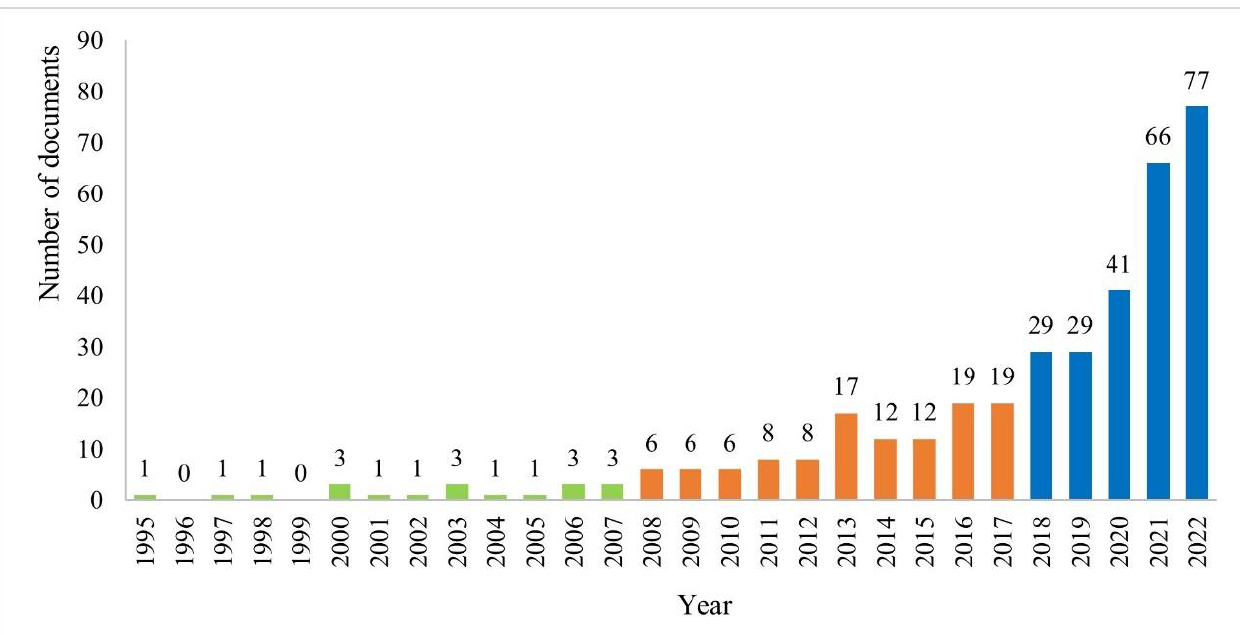
Figure 3. Annual number of documents considering the ecological and environmental effects of land use and cover changes (LUCC) on the Qinghai-Tibetan Plateau (QTP) from 1995 to 2022. Table 1. Number of papers issued by the top ten journals and corresponding h-indices considering the ecological and environmental effects of land use and cover changes (LUCC) on the Qinghai-Tibetan Plateau (QTP) from 1995 to